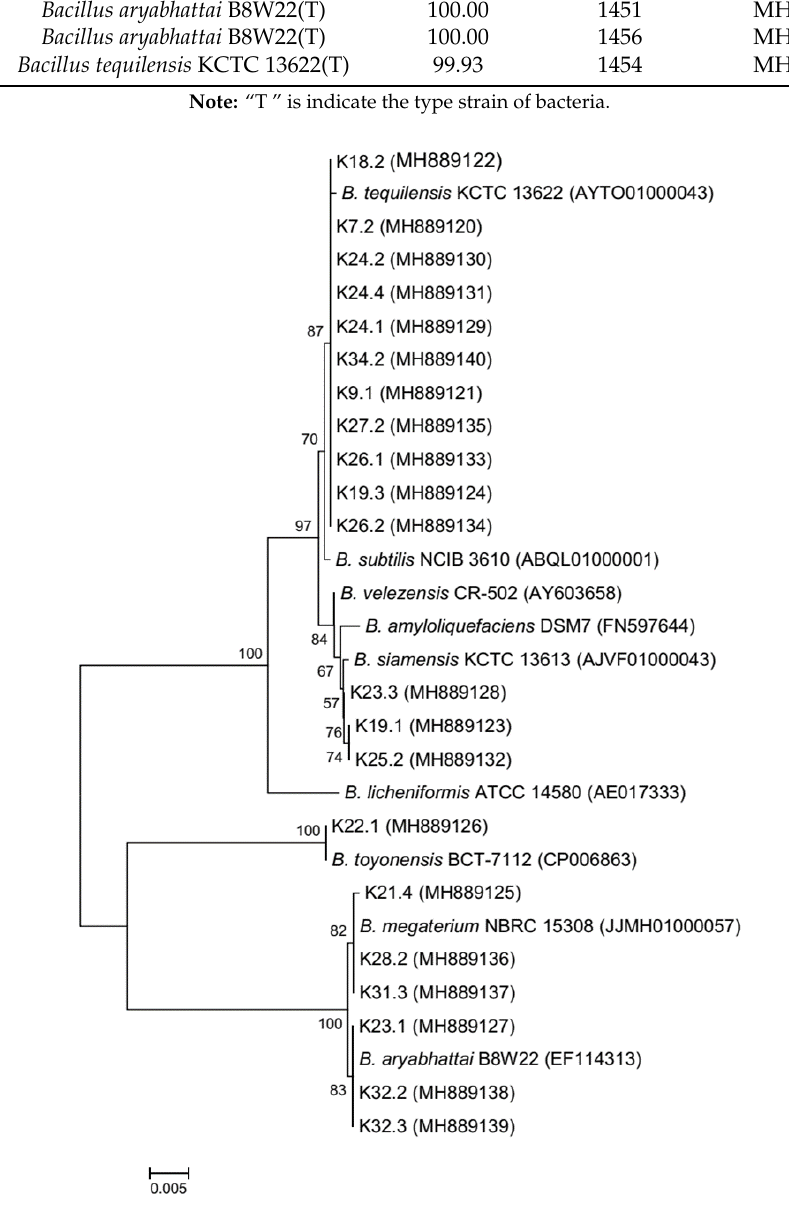
Figure 3. Neighbor-joining phylogenetic tree based on the 16S rRNA gene sequence of tannin-tolerant Bacillus spp. isolated from Miang and their related taxa.